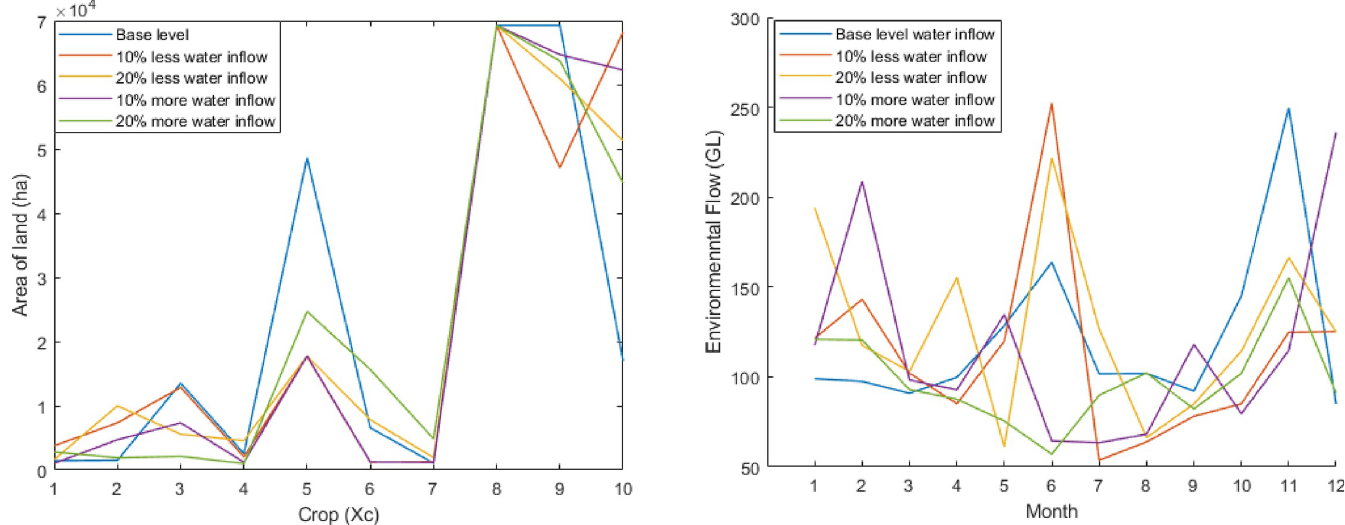
Fig 5. Effect of different water inflow on crops and environmental flow. (a) Crops pattern for different water inflow. (b) Environmental flow for different water inflow.